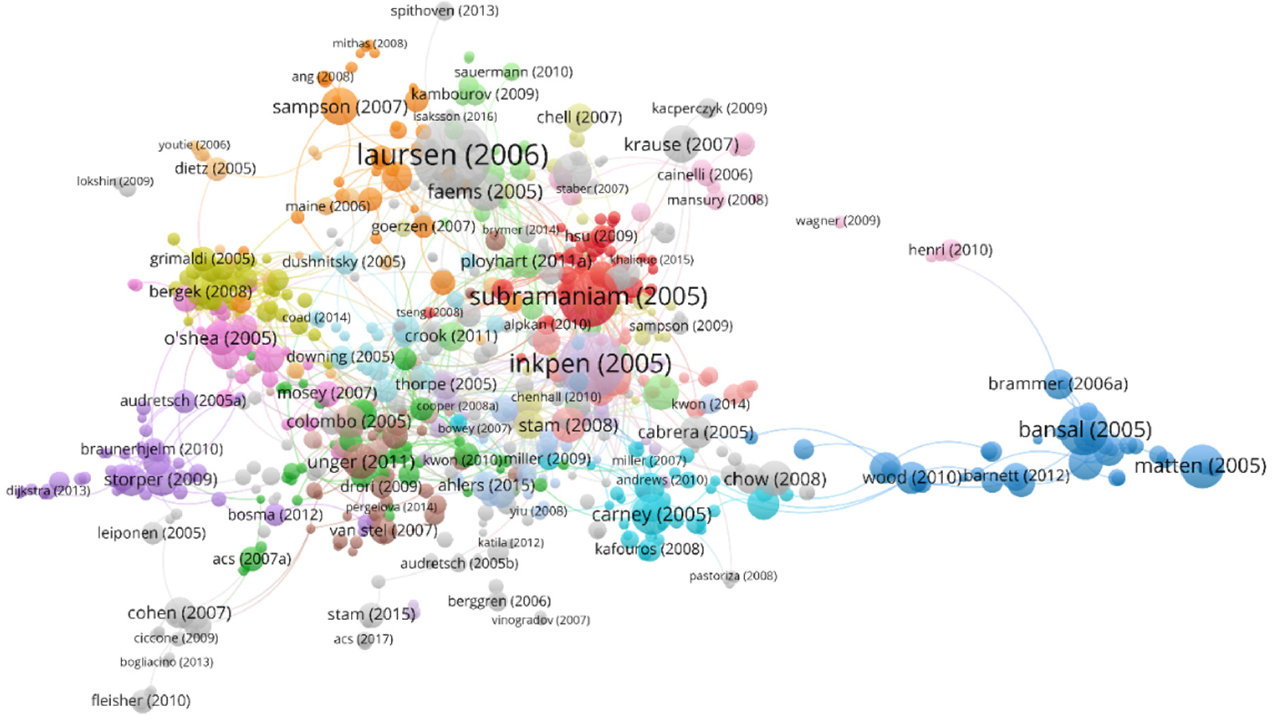
Figure 3. Number of publications per journal, top ten (Source: Own elaboration). In order to provide an accurate representation of the number of times an article is cited by other publications, a citation analysis is presented, using the VOSViewer software